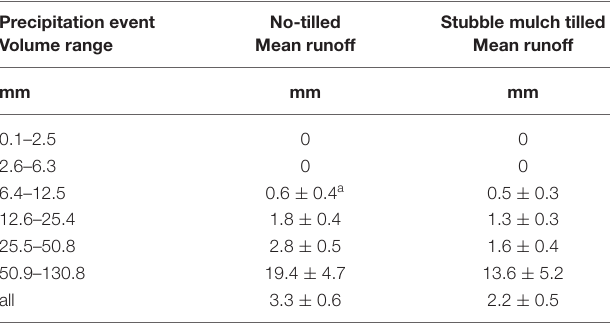
TABLE 4 | The effect of precipitation event volume and tillage system on mean runoff volume for data collected from plots in wheat-sorghum-fallow rotation from 1990 to 2009.